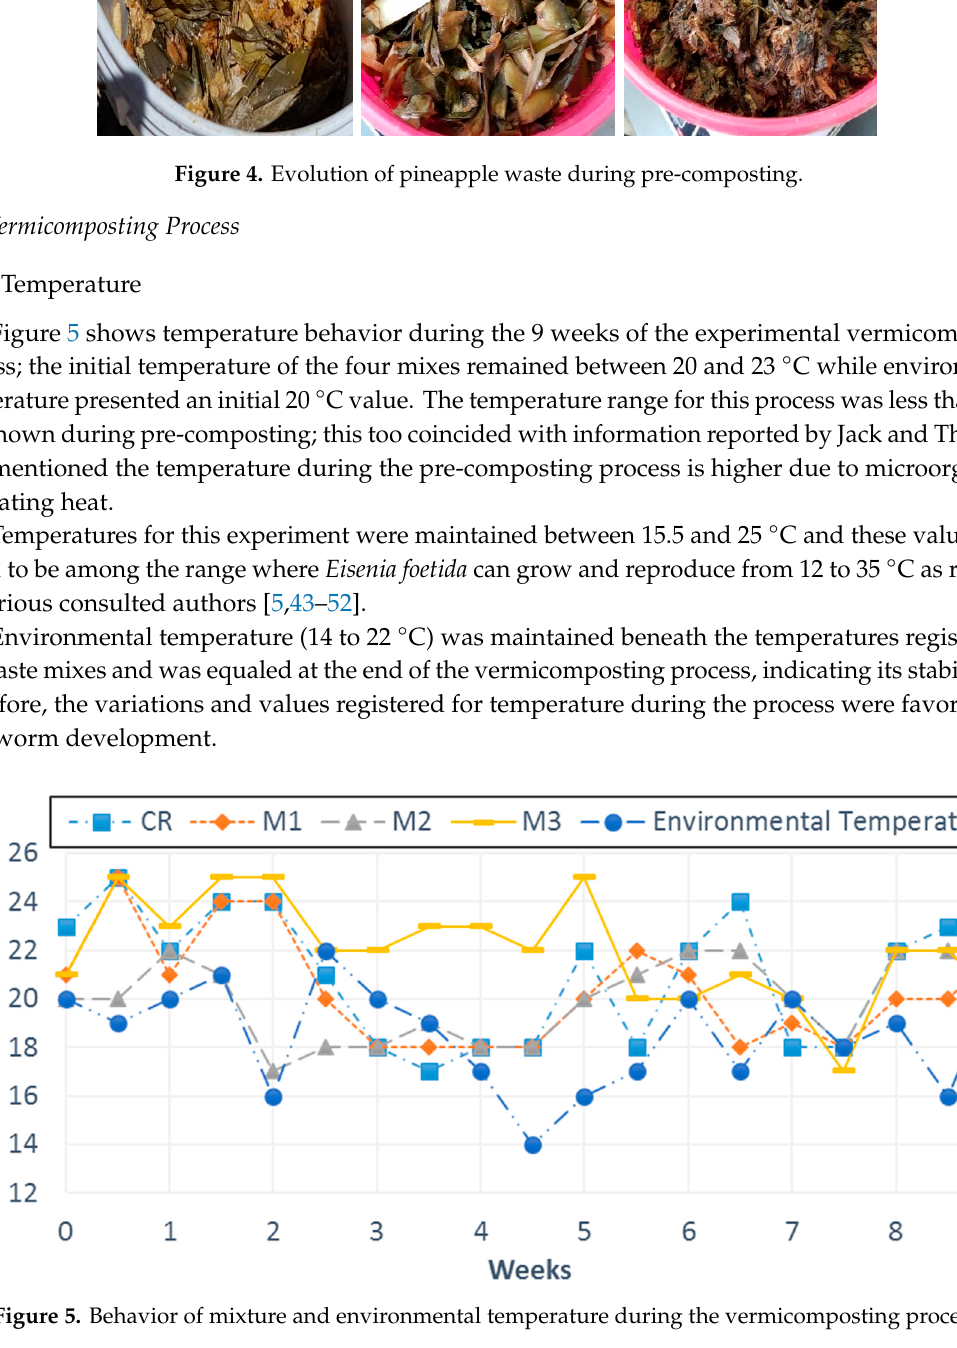
Figure 5. Behavior of mixture and environmental temperature during the vermicomposting